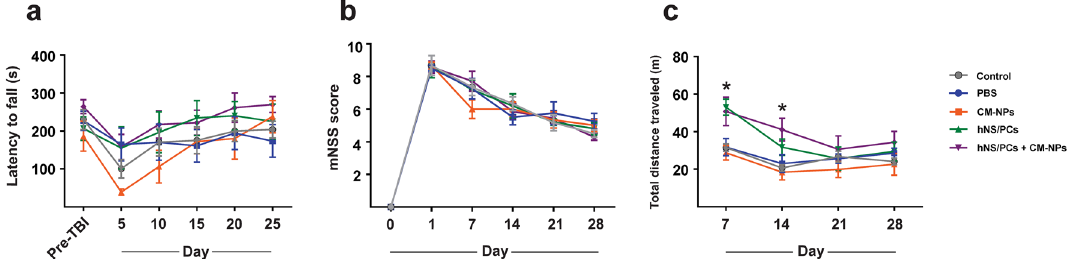
Figure 4. Rotarod, mNSS, and OF were assessed to evaluate the advanced locomotor function, sensory-motor function, and general locomotor activity in different groups following TBI. ( a ) The mean latency to fall on the rod showed no significant difference between groups in the rotarod test. ( b ) The statistical analysis showed no significant difference in mNSS scores between groups. ( c ) In the OF task, total distance traveled significantly increased in hNS/PCs and hNS/PCs + CM-NPs groups in comparison with the control, PBS, and CM-NPs groups on days 7 and 14. The data are shown as the mean ± SEM and * indicates P < 0.05 (n = 6).